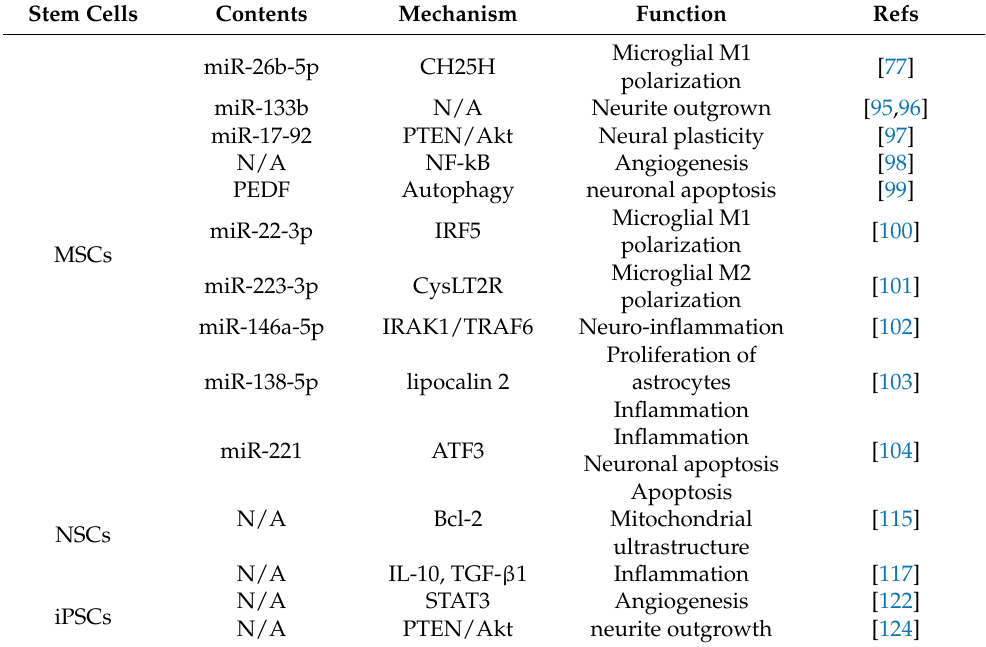
Table 1. Studies of stem cell-derived exosomes in cerebral I/R injury. Stem